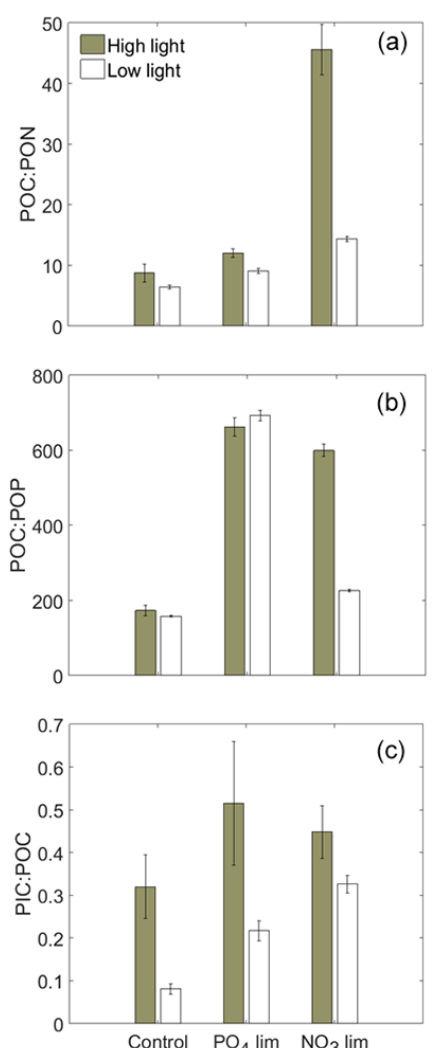
Figure 4. (a) POC quota vs. cell volume, (b) Cell volume vs. coc- cosphere volume in high-light (HL) and low-light (LL) conditions, (c) Distal shield length (DSL) vs. coccosphere and cell diameter. Solid symbols are cell size and open symbols are coccosphere size. Dotted line is the linear